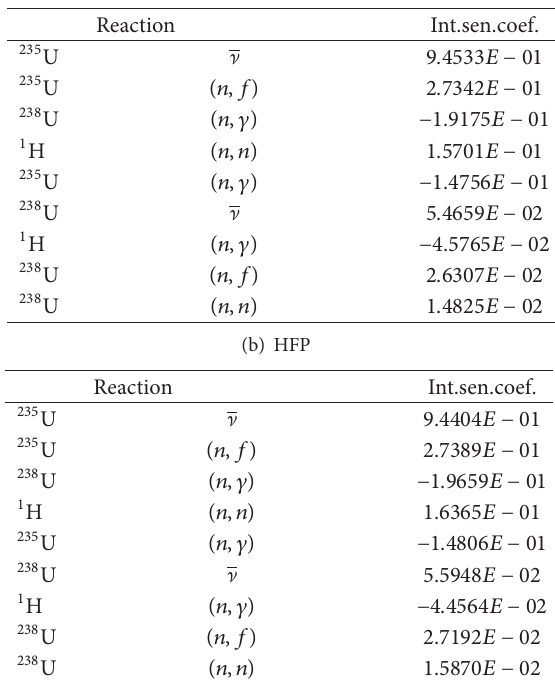
Table 6: Largest integrated sensitivity coefficients of the reaction cross sections for the rodded case at HZP and HFP sorted in descending order provided by